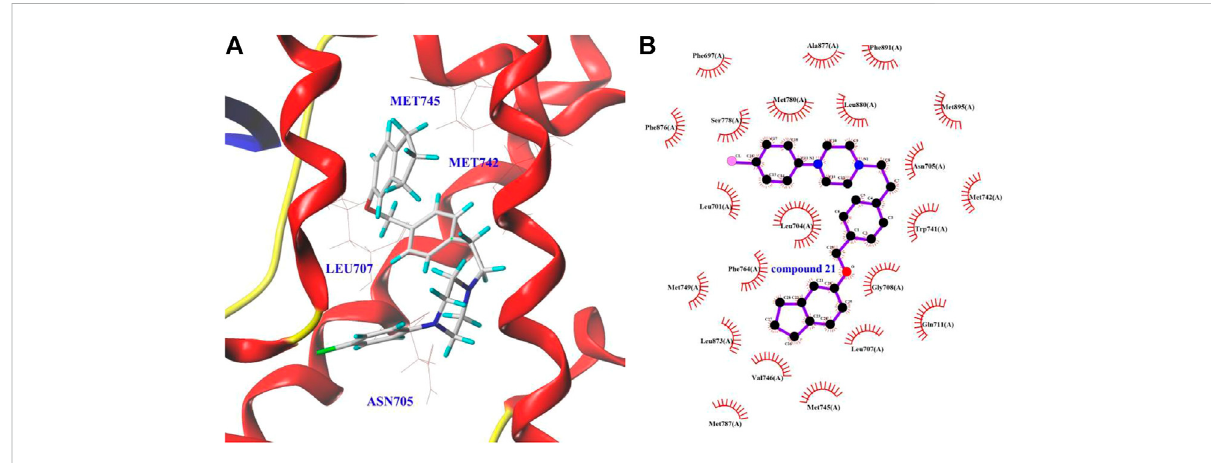
FIGURE 2 The docking view of compound 21 – AR